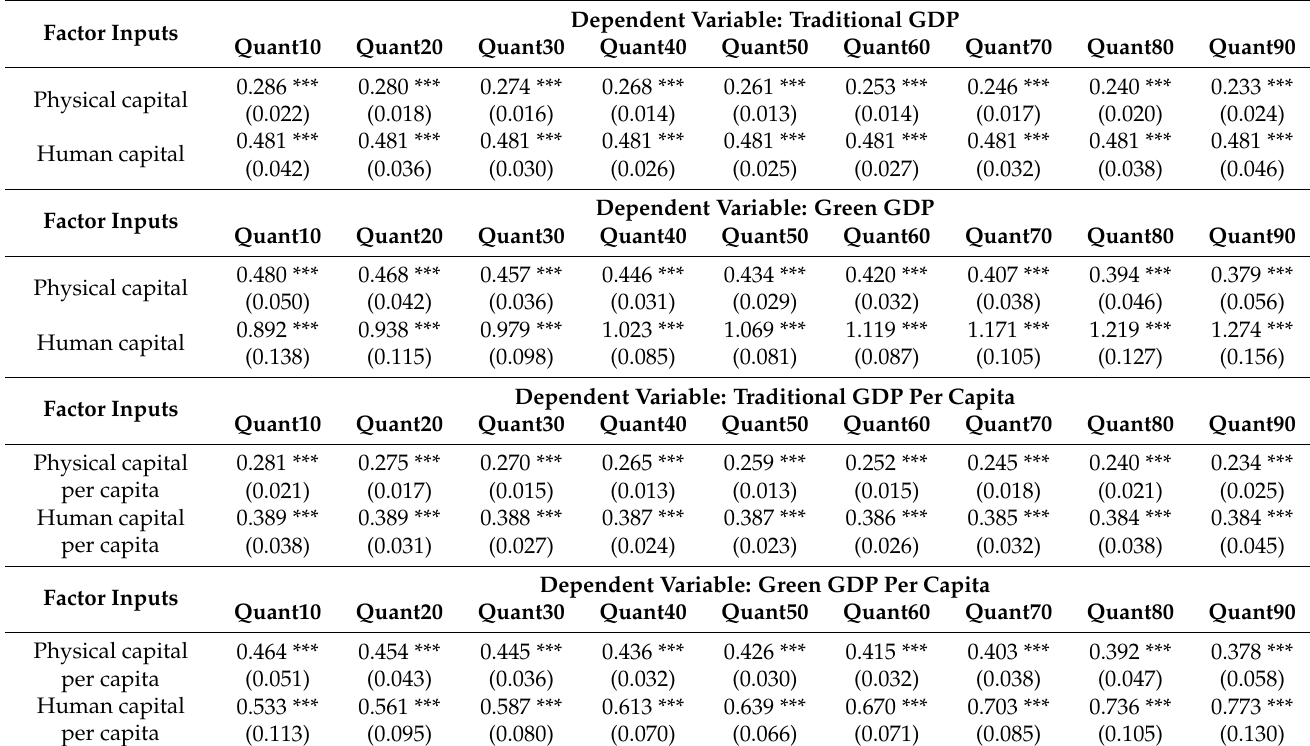
Table 6. Quantile regressions of GDP and green GDP on physical capital and human